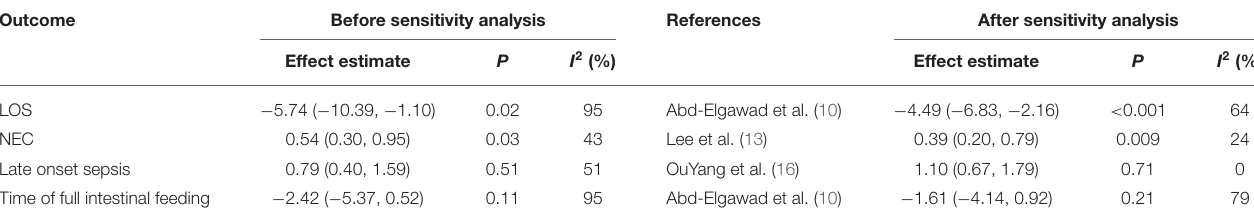
TABLE 2 | The sensitivity analysis results of LOS, NEC, late onset sepsis and time of full intestinal feeding. Outcome Before sensitivity